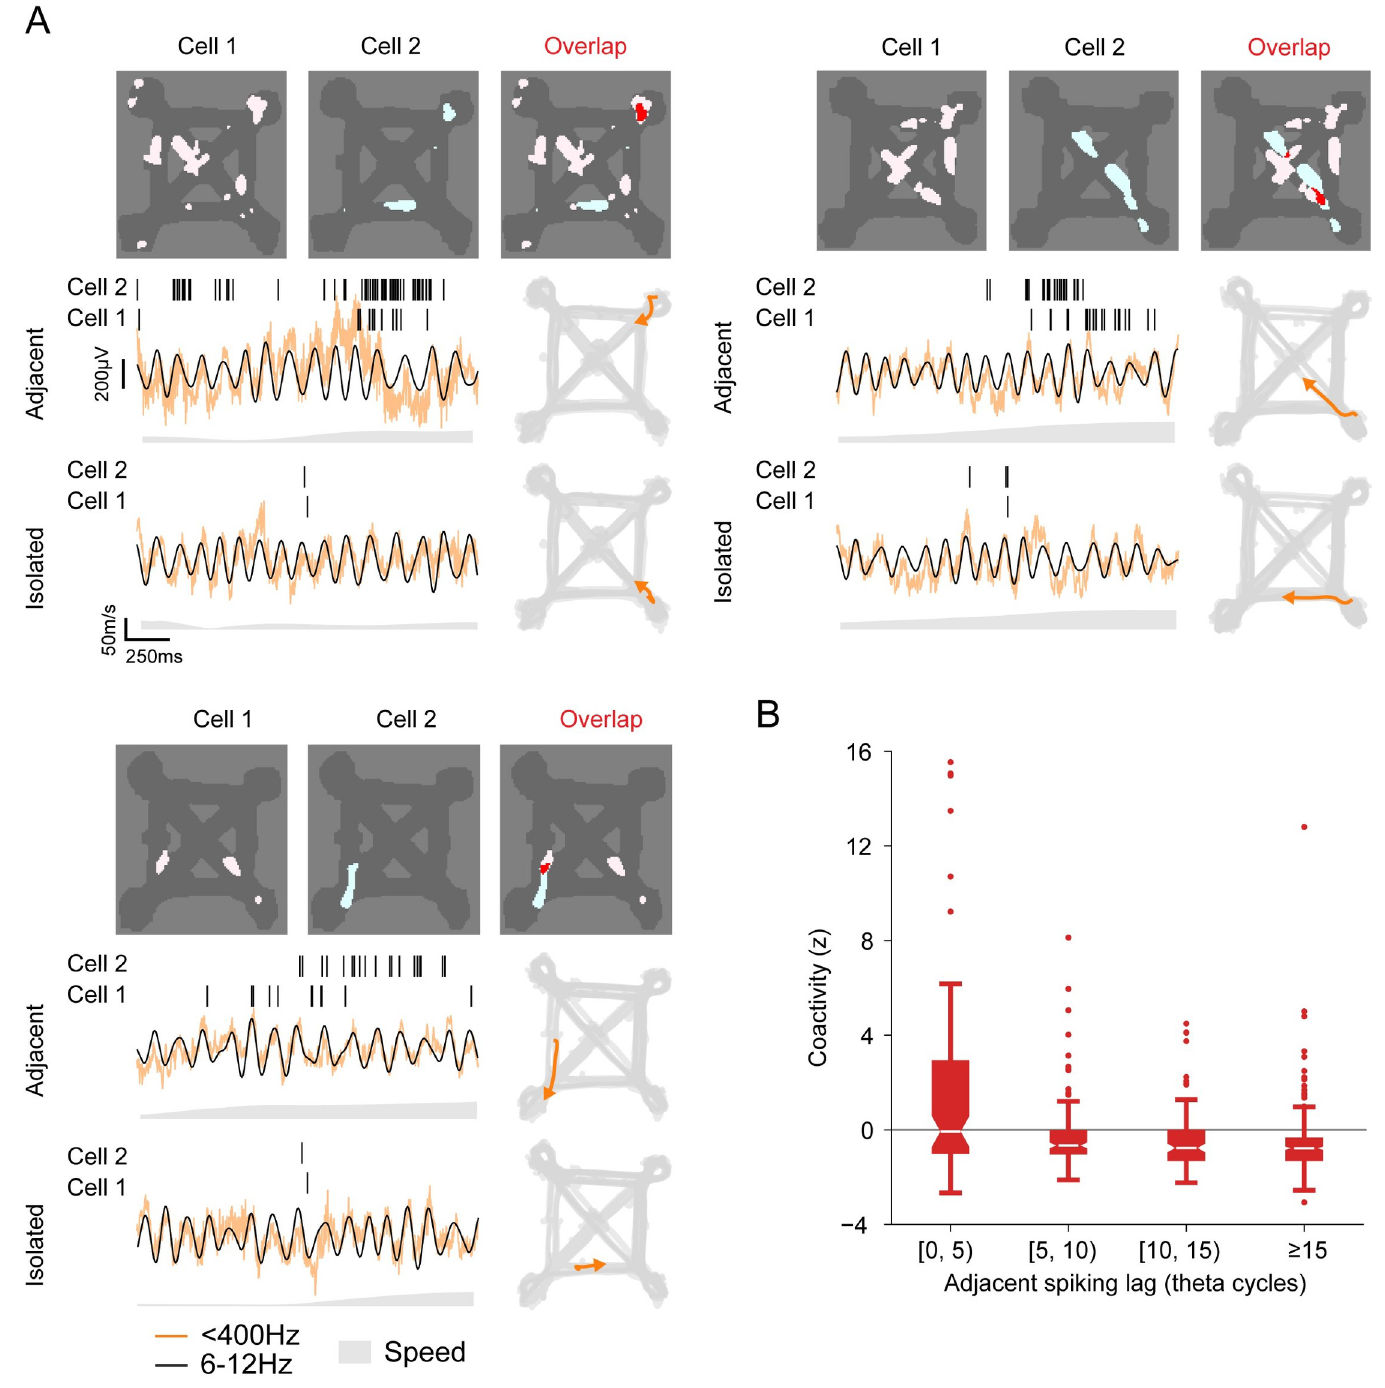
Fig 5. Reactivation of spatiotemporal place field activity relationships during theta cycles with isolated spiking activity. (A) Three pairs of CA1 cells with overlapping adjacent activity. The place fields (occupancy normalize spiking rate > 5 Hz) for each cell as well as their spatial overlap are shown. Example spiking bouts of adjacent and isolated activity are shown with raw and theta frequency band filtered LFP. The animal’s trajectory (orange line and arrow) on the maze for each bout is shown on the right. (B) Normalized coactivity (z) for CA1 cell pairs during theta cycles with isolated activity ( n = 425 pairs) grouped by the mean separation in time (mean lag) between their adjacent activity (R = − 0.28, R 2 = 0.077, p = 6.40 × 10 − 9 ). LFP, local field potential.